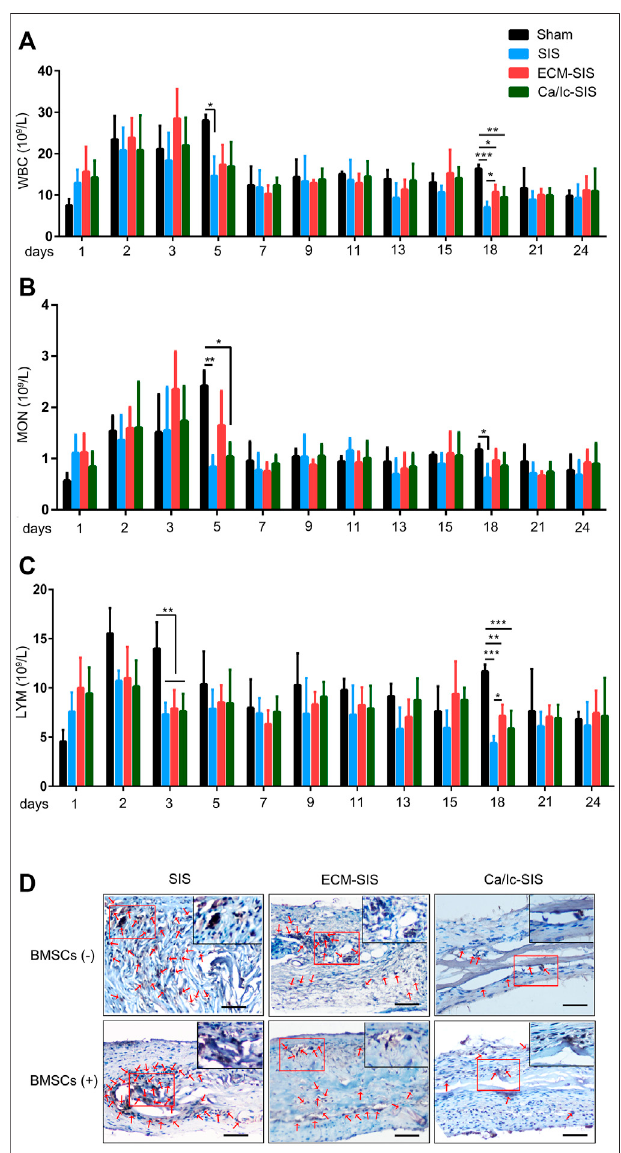
FIGURE 1 | Histogram of (A) white blood cells (WBCs), (B) monocytes (MONs), and (C) lymphocytes (LYMs) counts as a function of time (days) after the operation. Mean +S.D. ( n (cid:1) 4). *, p < 0.05; **, p < 0.01, and ***, p < 0.001. (D) IHC staining of CD68 in the six scaffolds (SIS, ECM-SIS, Ca/Ic-SIS, SIS+BMSCs,ECM-SIS+ BMSCs,and Ca/Ic-SIS+BMSCs) at 8 weeksafter